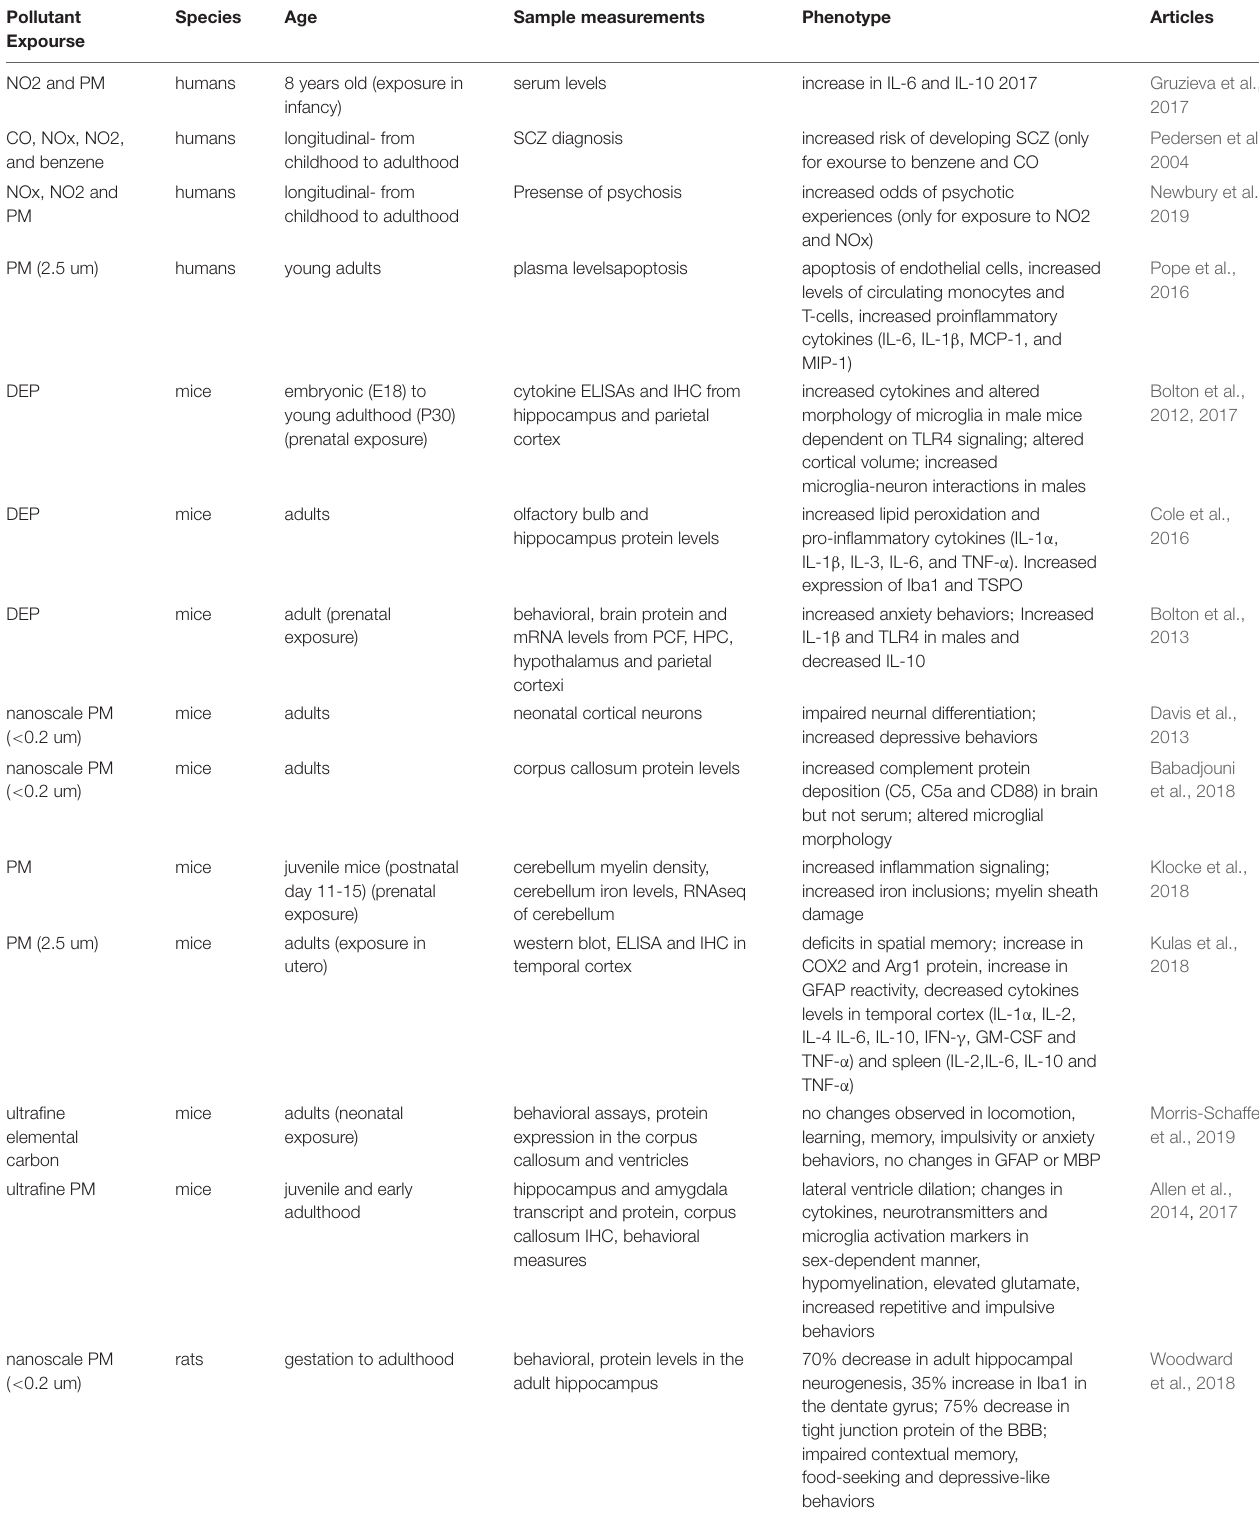
TABLE 1 | Overview of the effects of different pollutants on